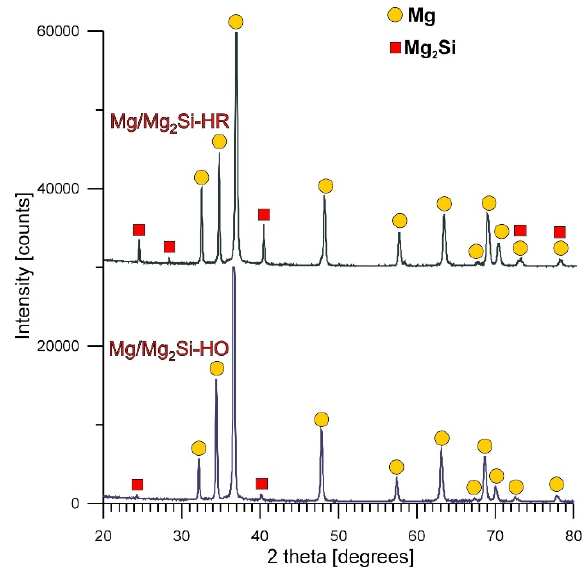
/ Mg 2 Si–HO and Mg 2 Si–HR